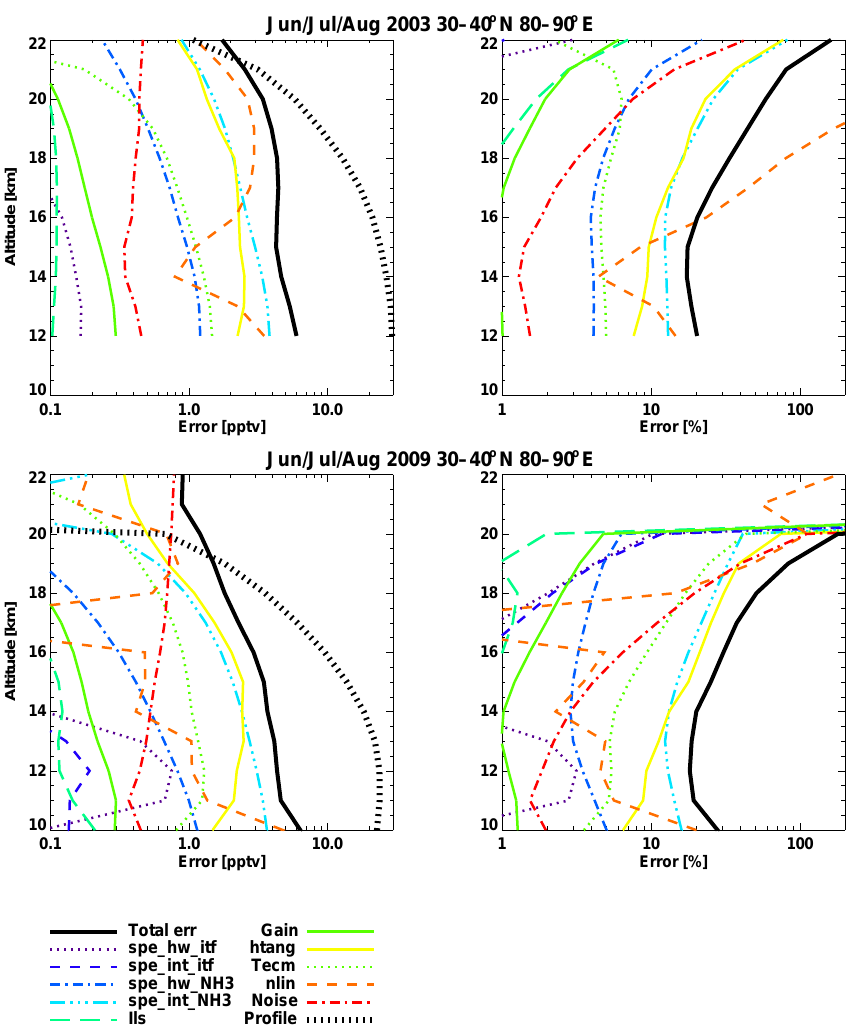
Figure 2. Estimated error profiles for two examples: one from measurement period 1 (June, July, and August 2003; 30–40 ◦ N, 80–90 ◦ E) and one from period 2 (June, July, and August 2009; 30–40 ◦ N, 80–90 ◦ E). The retrieved NH 3 profiles are shown as bold black dotted lines (“profile”). Abbreviations of the error sources are resolved in Table